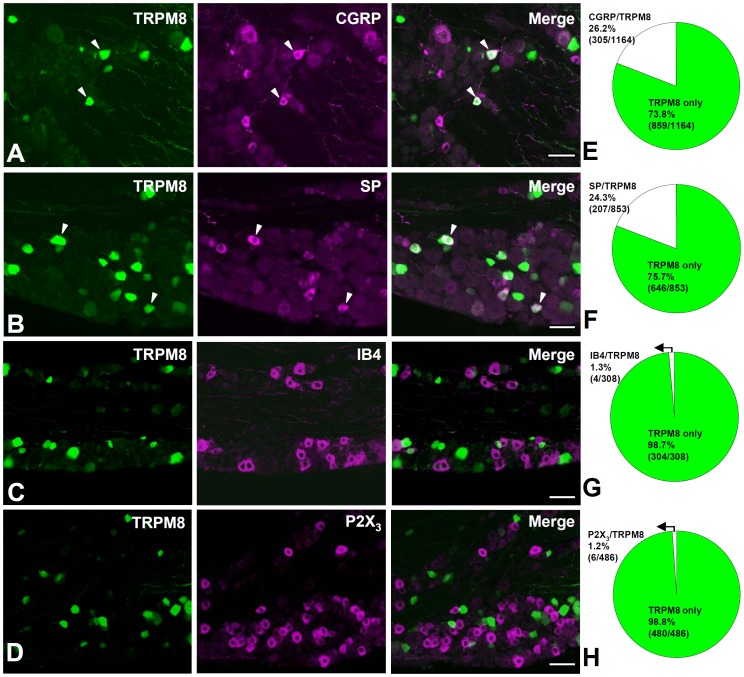
Histochemical characterization of TRPM8+ neurons in the trigeminal ganglion.(A–D) Double-immunofluorescence staining for Trpm8GFP and markers for peptidergic C nociceptive neurons, CGRP (A) and SP (B), and for non-peptidergic C nociceptive neurons, IB4 (C), and P2X3 (D). colocalization is represented in white in the merged images (arrowheads). (E–H) Quantitative analysis of the co-staining of Trpm8GFP with CGRP (E), SP (F), IB4 (G), and P2X3 (H). Of all TRPM8+ neurons, 26.2% (305/1164 in 12 sections) co-stain for CGRP, 24.3% (207/853 in 11 sections) co-stain for SP, 1.3% co-stain for IB4 (4/308 in 10 sections), and 1.2% co-stain for P2X3 (6/486 in 10 sections). Scale bars  = 50 μm.